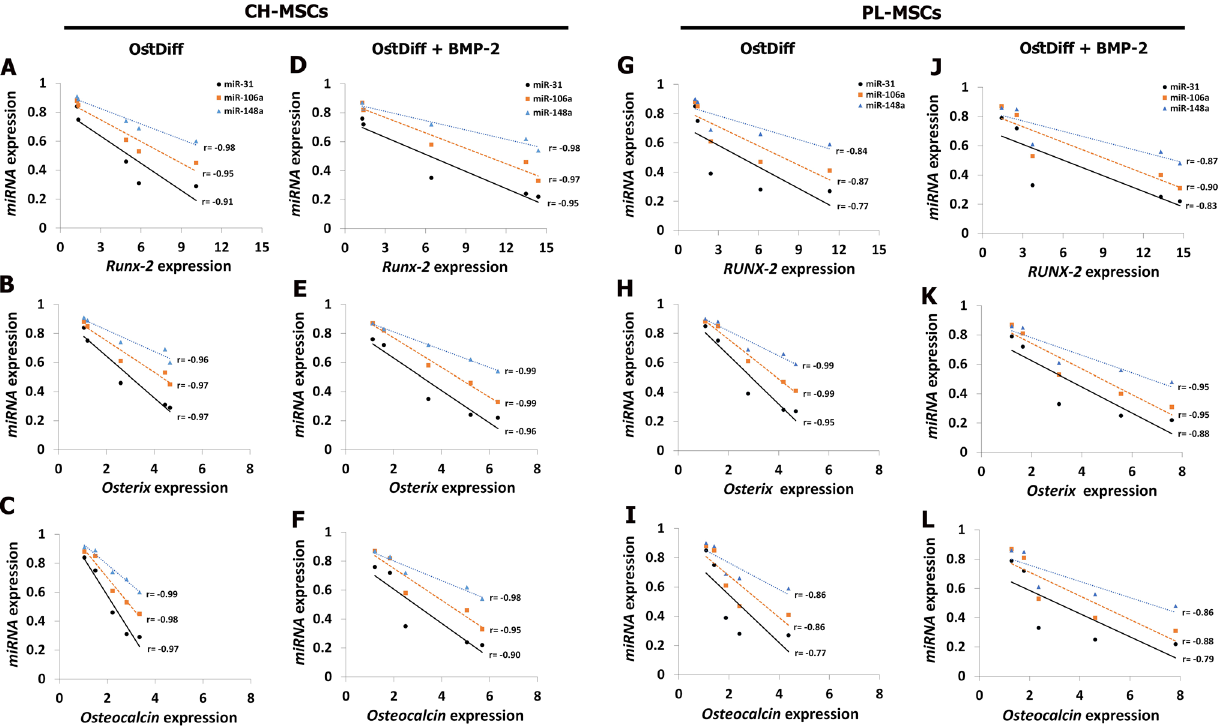
Figure 5. Correlations between the expression of osteogenic marker genes and the expression of miRNAs in CH-MSCs ( A – F ) and PL-MSCs ( G – L ) cultured in osteogenic differentiation medium with or without